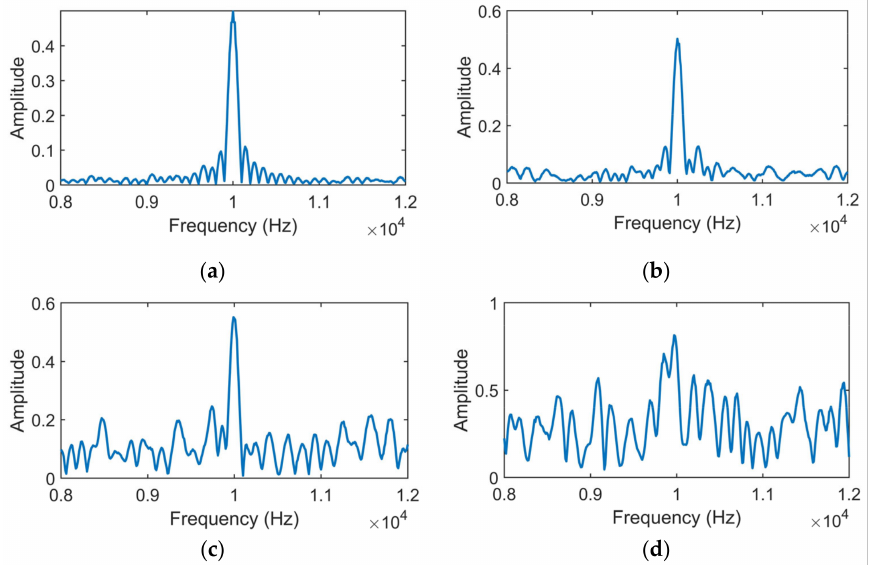
Figure 7. Cross-correlation spectra of different SNR; ( a ) 10 dB; ( b ) 0 dB; ( c ) − 10 dB; and ( d ) − 20